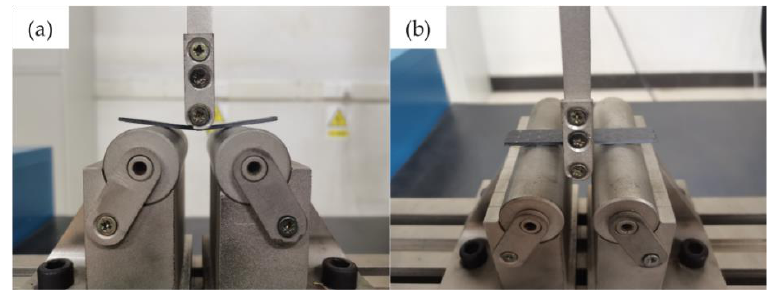
Figure 4. Loading diagrams of three-point bending. ( a ) Front view of composite specimen under three-point bending load; ( b ) Top view of